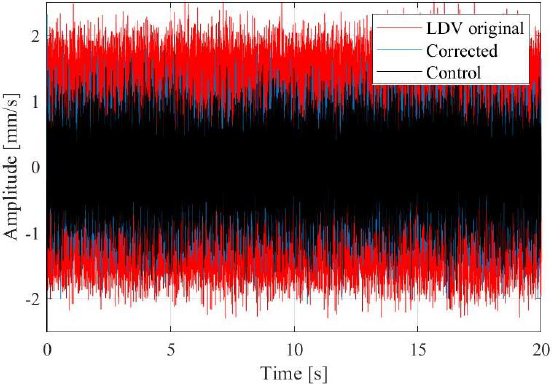
Figure 7. Comparison of the time series of the original vibrometer signal (red), control signal from the accelerometer (black), and the corrected vibrometer signal (blue) after the mathematical procedure is applied.